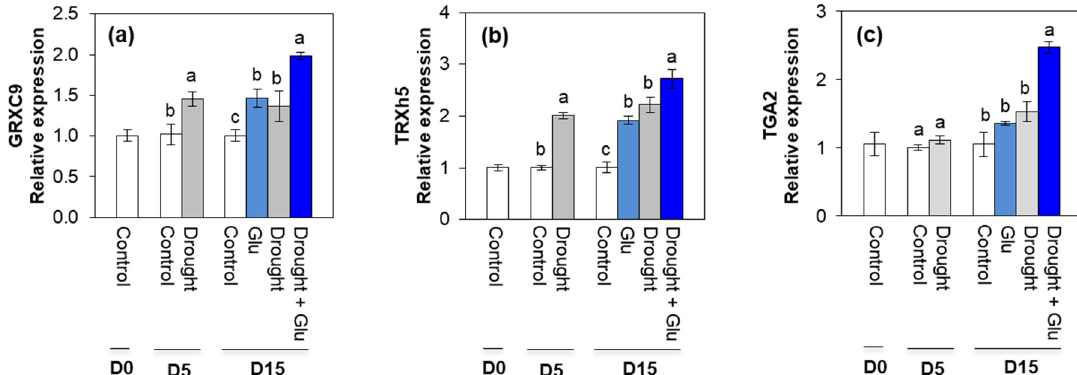
Figure 6. Effect of glutamate (Glu) application on the genes expression of redox signaling in leaves of Brassica napus under well-watered or drought-stressed conditions. ( a ) CC-type glutaredoxin 9 ( GRXC9 ), ( b ) thioredoxin-h5 ( TRXh5 ), and ( c ) TGA-box transcription factor ( TGA2 ). qRT-PCR was performed in duplicate for each of the three independent biological samples. Values are represented as mean ± SE ( n = 3). Different letters on columns indicate significant difference at p < 0.05 according to Duncan’s multiple range test.